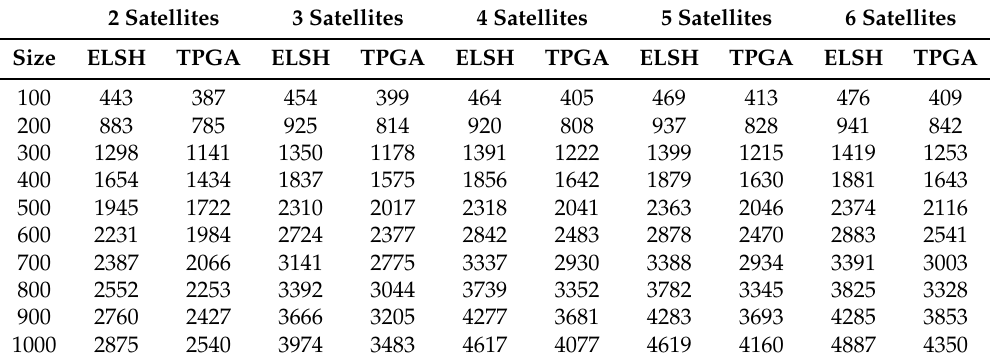
Table 4. Comparison with TPGA on the total profit on area distribution instances.